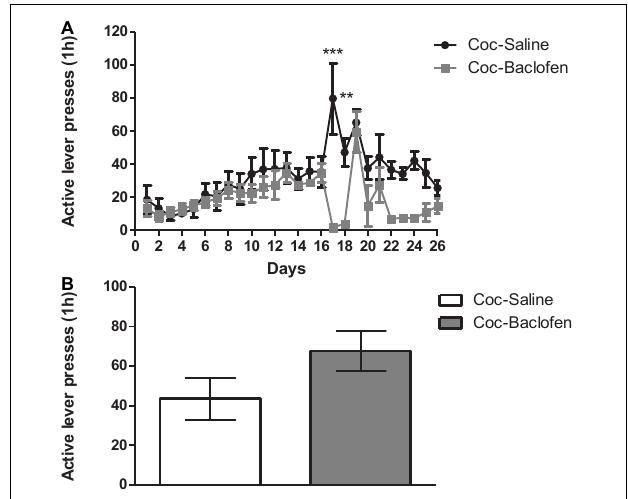
FIGURE 1 | Effects of a dose of 3.2 mg/kg of baclofen on extinction, withdrawal and reinstatement phases in a cocaine (Coc) self-administration (SA) rat model. (A) Effect of baclofen on cocaine-seeking during extinction and withdrawal phases. Rats ( n = 6) were trained for cocaine (0.5 mg/kg) or saline SA on days 1–16. Coc-Saline, control, trained for cocaine SA and received saline at the withdrawal phase, and Coc-Baclofen, trained for cocaine SA and received baclofen (3.2 mg/kg) at the withdrawal phase. Baclofen treatment, given on days 17–18, significantly reduced cocaine-seeking behavior throughout extinction training, compared with saline-treated controls. A two-way ANOVA with repeated measures revealed a significant effect of treatment [ F (1, 250) = 13.93, p = 0.0039], time [ F (25, 250) = 4.77, p < 0.0001], and the interaction between them [ F (25, 250) = 3.11, p < 0.0001] (Bonferroni, *** p < 0.001 day 17, ** p < 0.01 day 18). A lack of baclofen administration on day 19 increased active lever